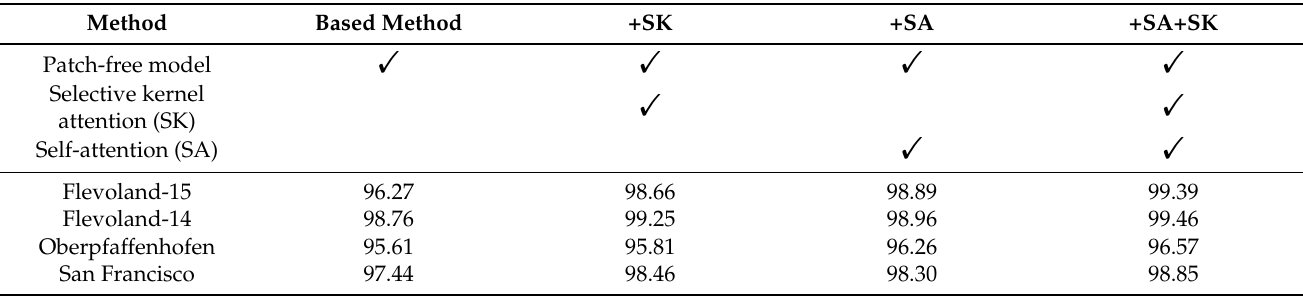
Table 10. Performance contribution of each module in